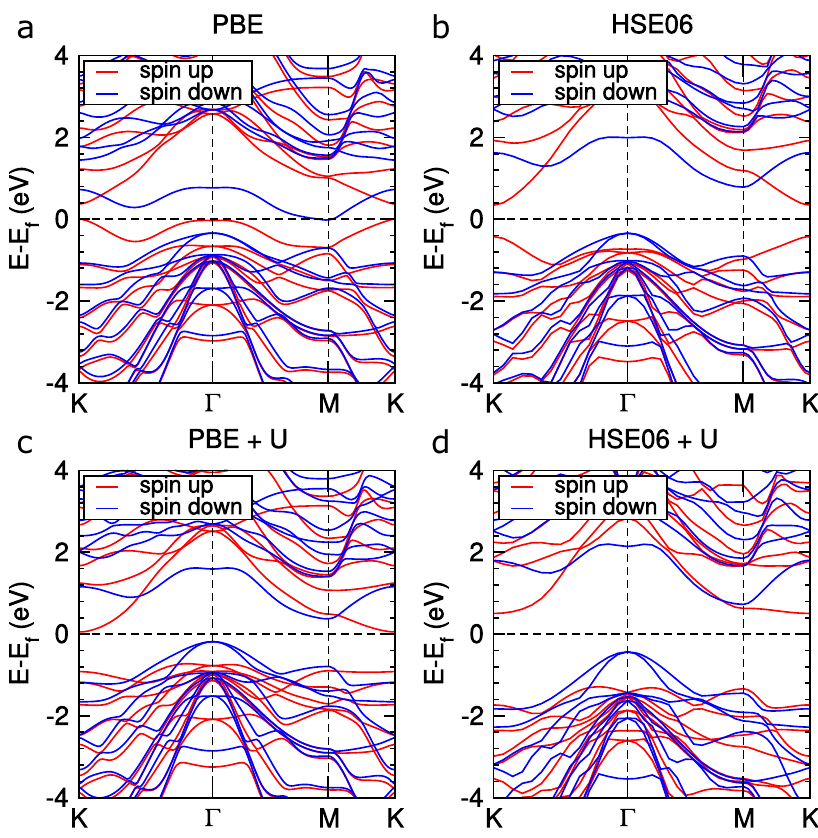
Fig. 4 Band structures of ferromagnetic δ 4 -VSi 2 P 4 under different methods. a , b Plots for PBE calculations with and without Hubbard U . c , d Corresponding plots for HSE06